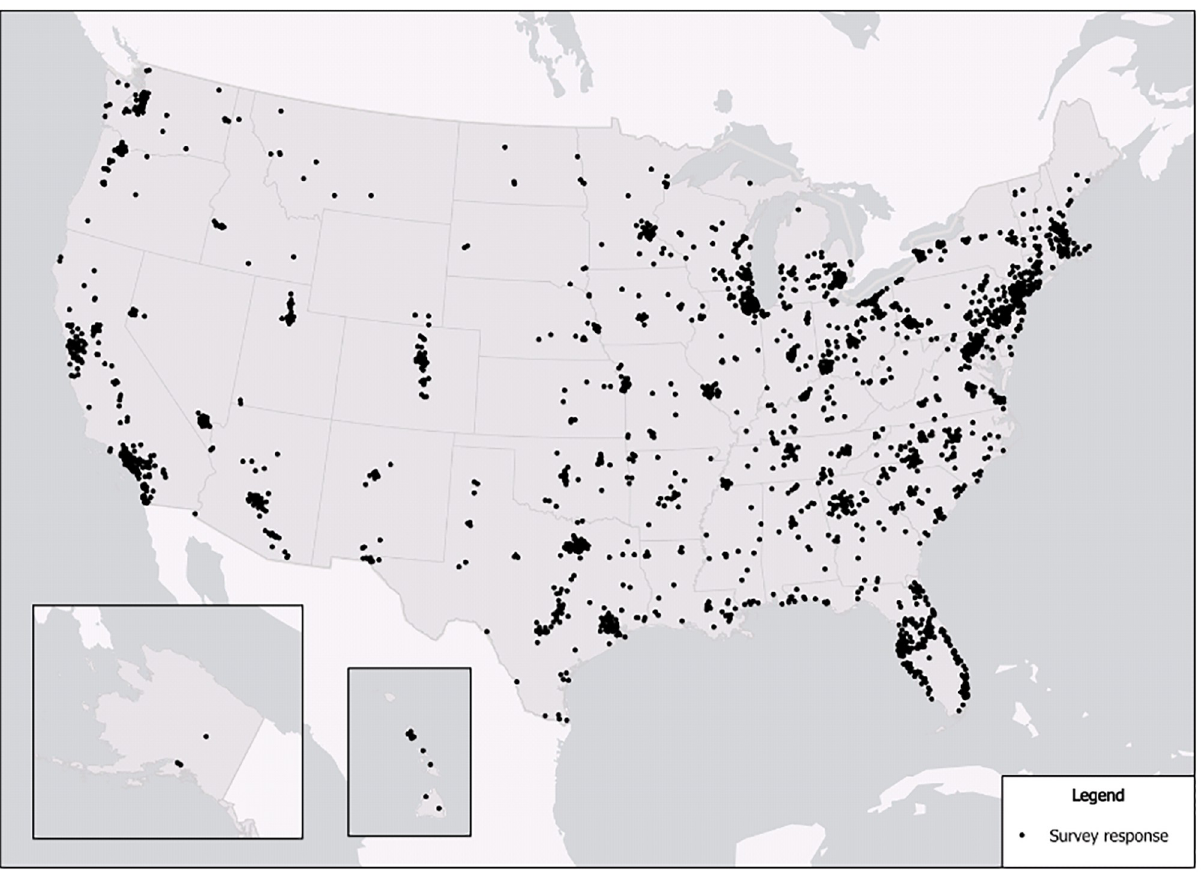
Fig 1. Location of